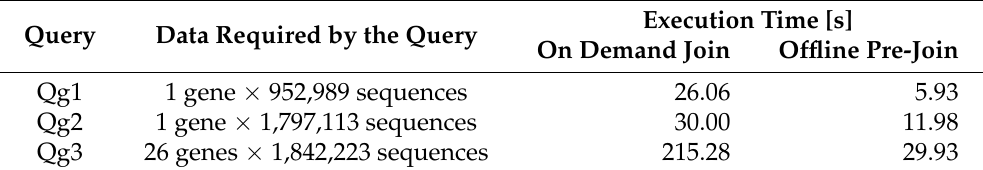
Table 3. Execution times and rough estimate of the resources involved for running the queries Qg1–3 of Table 2.